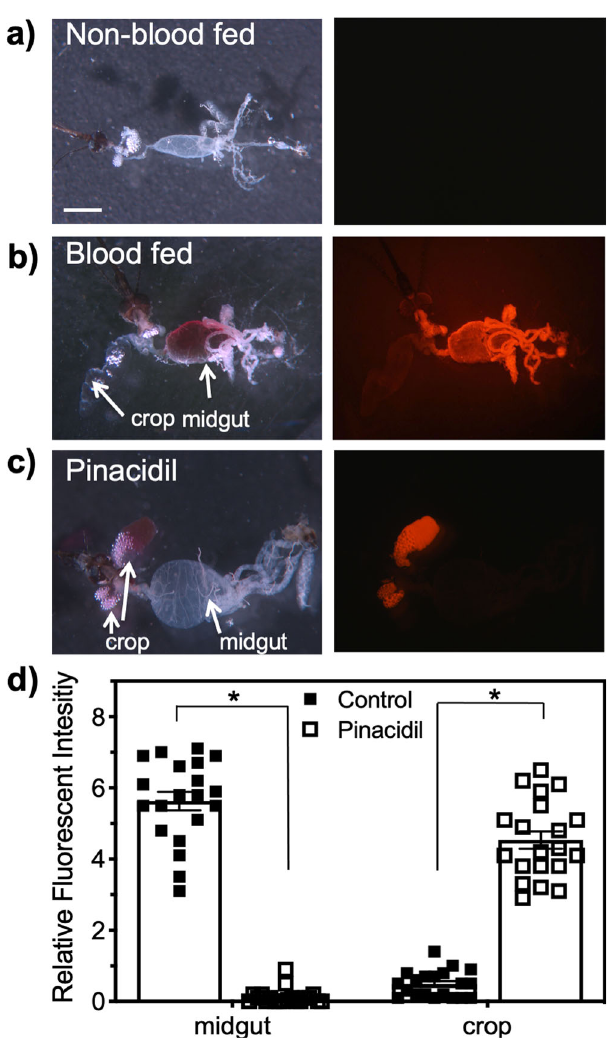
Fig. 4 K ATP activators alter the traf fi cking of blood meal. Representative images of individual mosquitoes indicating altered traf fi cking to the crop in mosquitoes that were unfed ( a ), blood with solvent only (control, b ), and fed on pinacidil ( c ) treated blood. Scale bar equals 500 µ m. Representative fl uorescent images are shown next to white light and were taken by fl uorescence microscopy using a rhodamine fi lter cube (excitation wavelength, 540 nm; emission wavelength, 625 nm) with an exposure time of 300-ms. d Blood traf fi cking to the crop or midgut was quanti fi ed by relative Rhodamine B (red) fl uorescence intensity. Bars represent mean ( n = 20 individuals) and error bars represent SEM. Asterisks represent statistical signi fi cance at P < 0.0001 as determined by a one-way ANOVA with Tukey ’ s posttest between control and pinacidil treatment groups. See Supplemental Data 4 for underlying